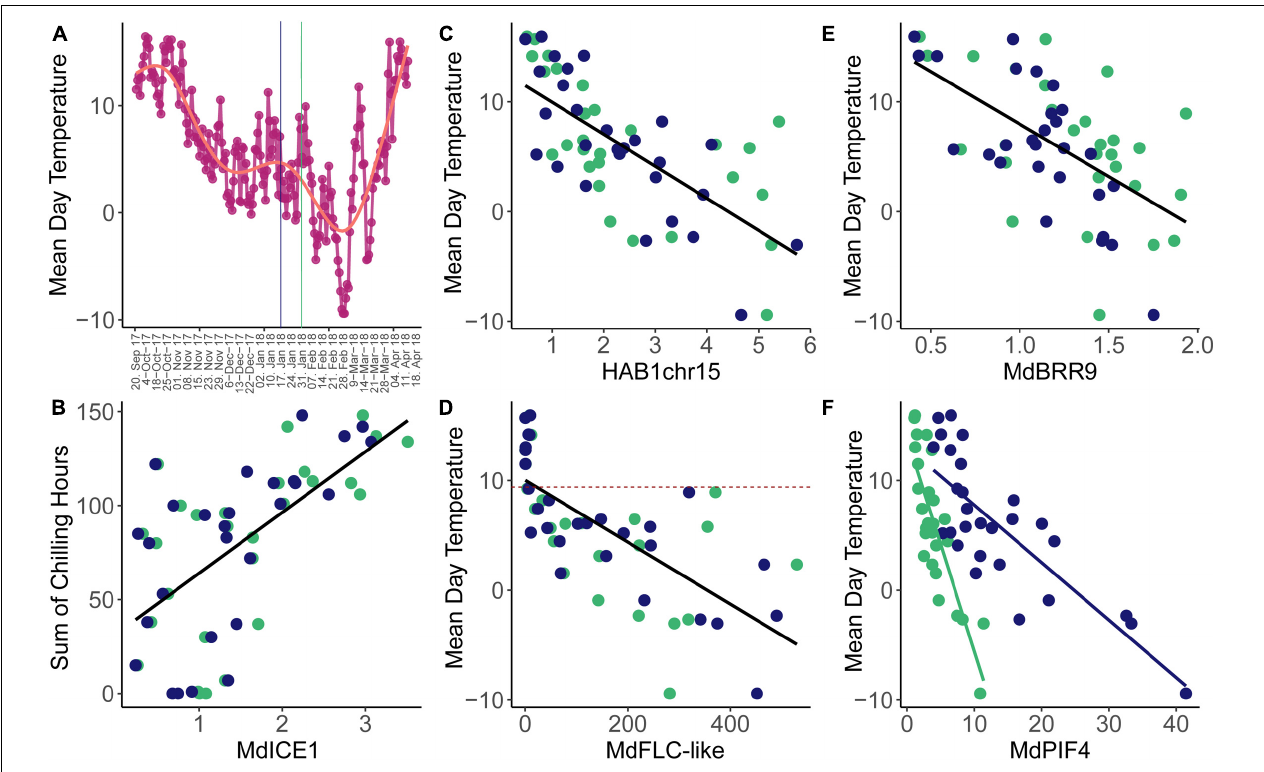
FIGURE 4 | Correlations observed between expression levels and temperature traits. (A) Mean daily temperature varied from the first to the last time point of sampling. Vertical lines indicate the timing of the transition from endodormancy to ecodormancy as in Figures 1 – 3 . (B) MdICE1 mean expression levels per time point correlated significantly with the amount of CH that accumulated during the 2 weeks before sampling. (C) HAB1chr16 mean expression levels were highly correlated with mean daily temperature, similar to MdFLC-like (D) and MdBRR9 (E) . The dashed lines indicate the mean daily temperature of 9.2 ◦ C (D) . (F) The slopes of the linear correlation differ between the two genotypes in MdPIF4 differed. Blue and green dots represent ‘Pinova’ and ‘Gala’ samples,